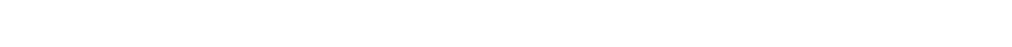
Frontiers in Neurology |